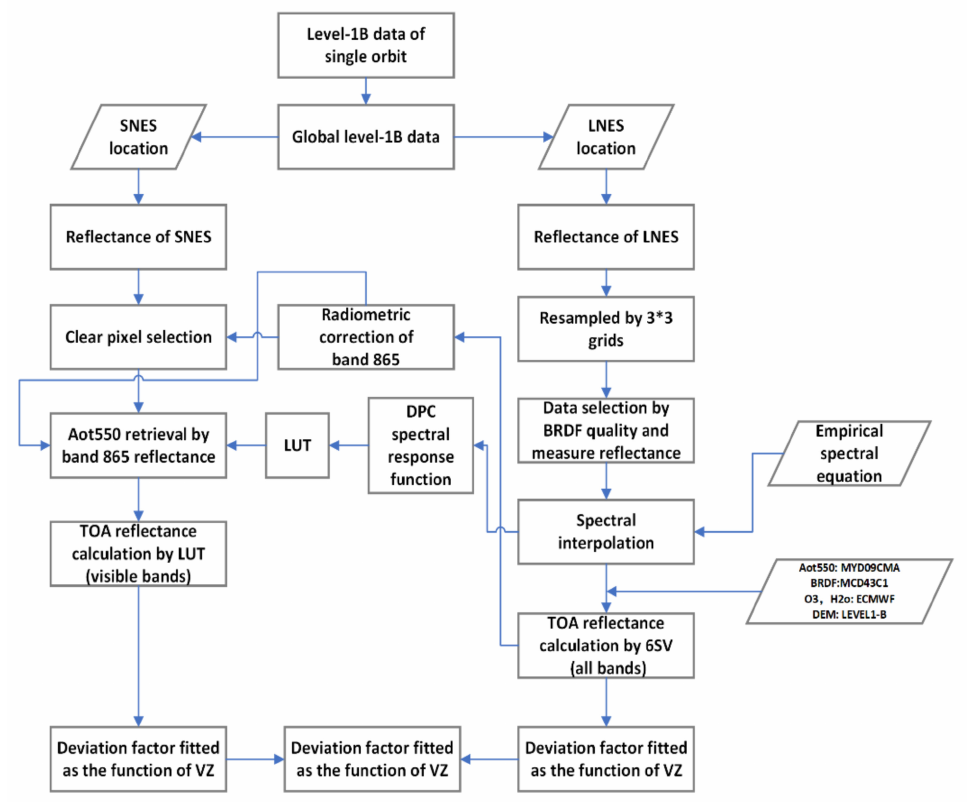
Figure 2. In-flight calibration flow chart of a DPC over an LNES and an SNES. First, the level-1B data of the DPC (approximately 15–16 orbits per day) are combined into one global dataset; this step assumes that the calibration coefficient will not vary